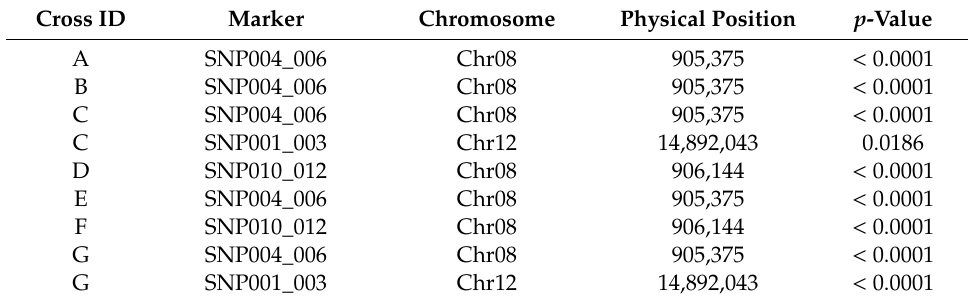
Table 2. Association analysis between markers and the fuzzless trait. SNP: single nucleotide polymorphism. Cross